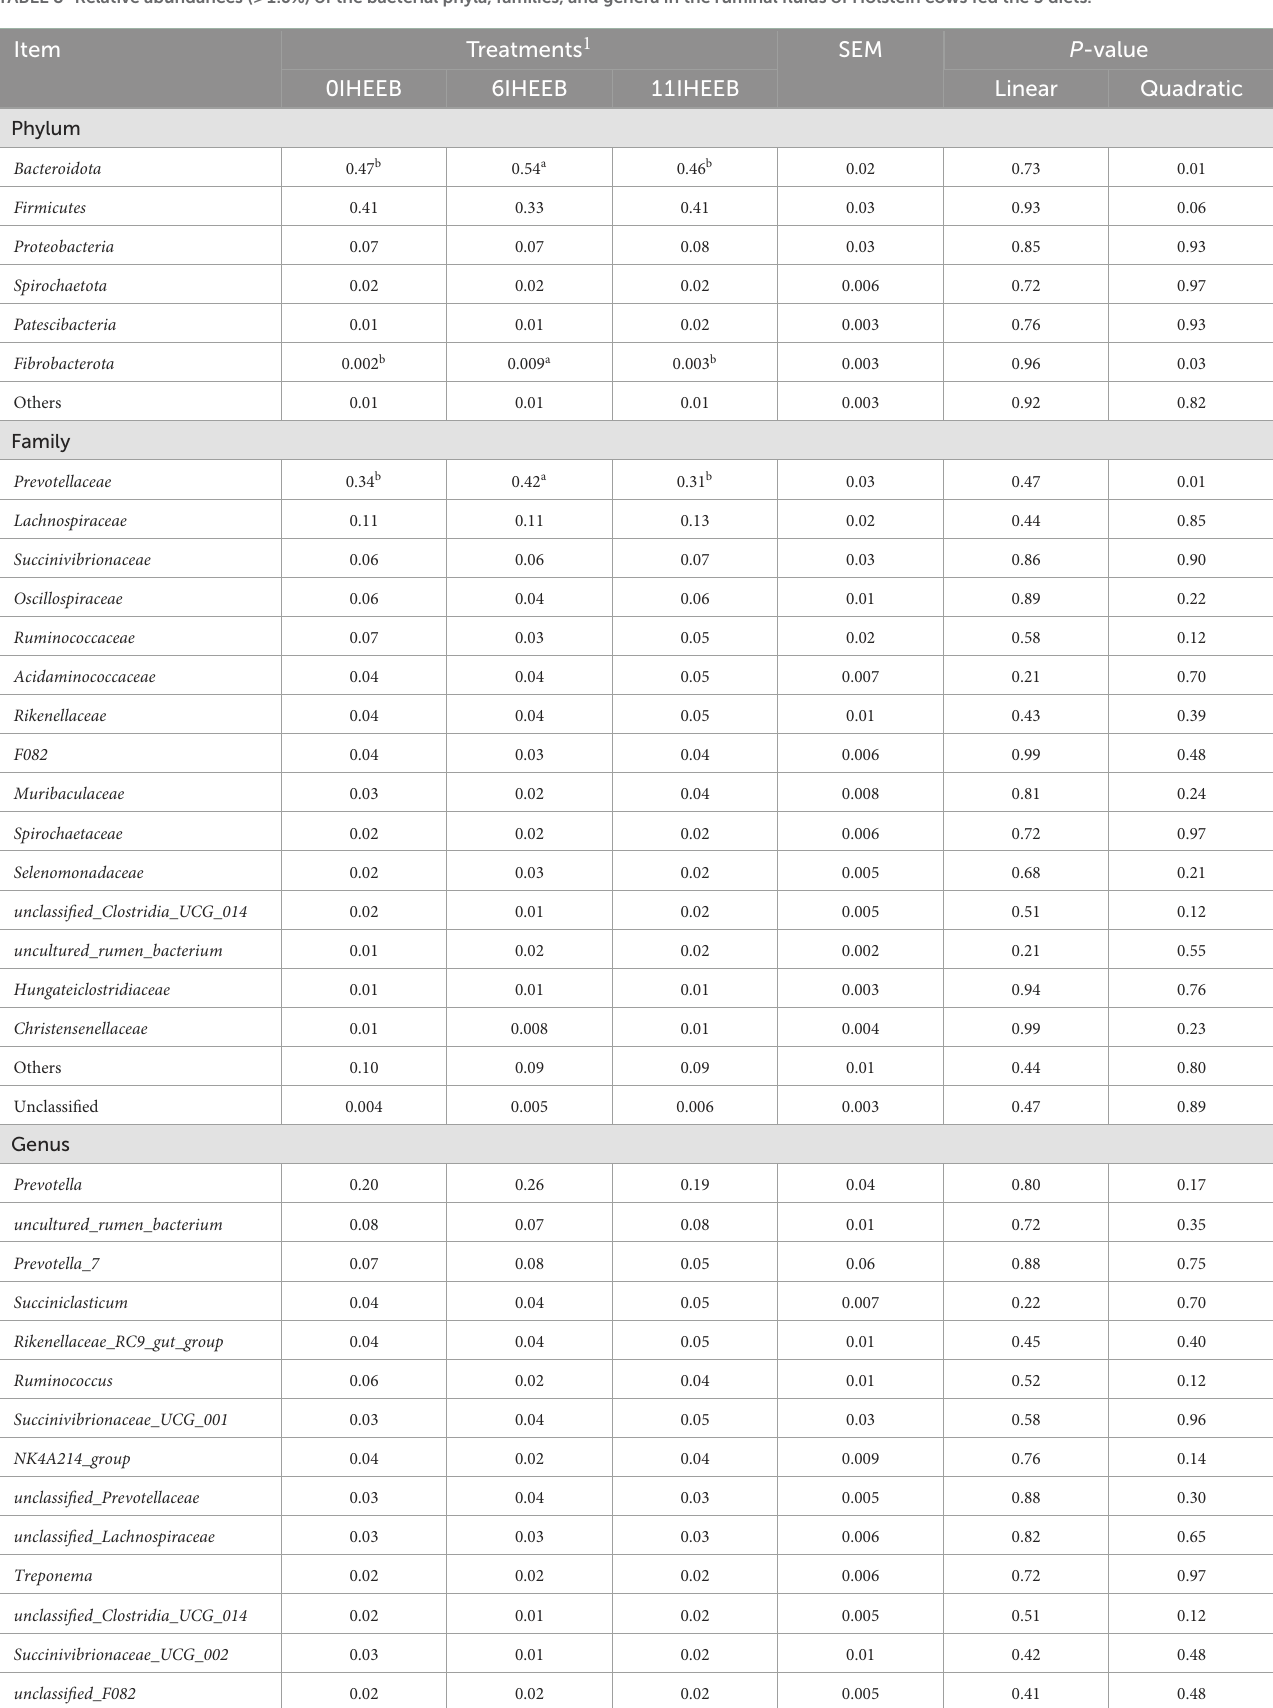
TABLE 8 Relative abundances ( > 1.0%) of the bacterial phyla, families, and genera in the ruminal fluids of Holstein cows fed the 3